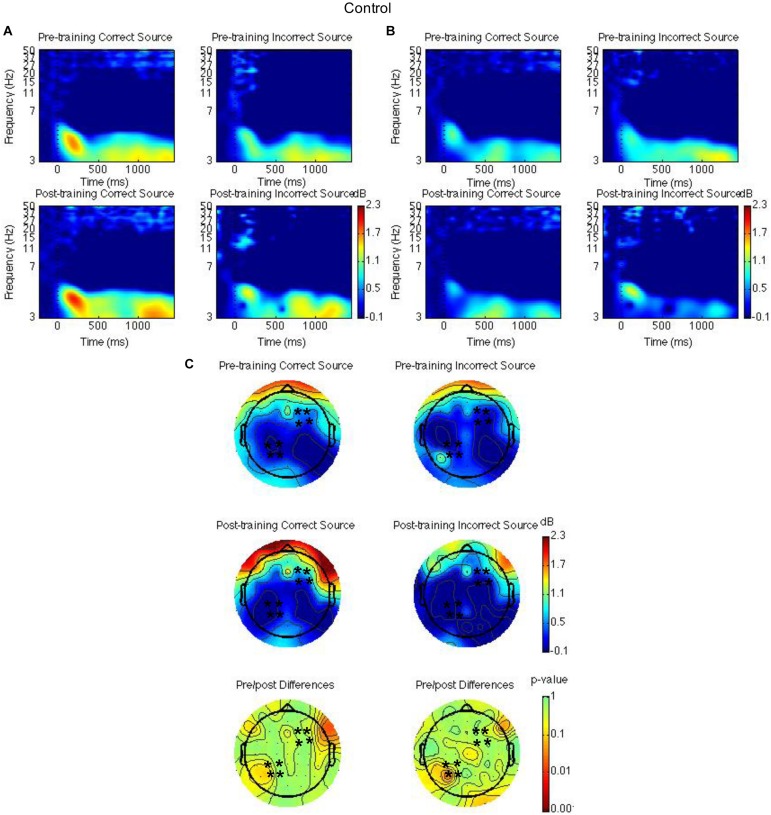
Theta power for the waitlist control group for the pre-training compared to the post-training session for hits with correct source and hits with incorrect source. Time-frequency spectrograms across times and frequencies in a right frontal channel (A). Time-frequency spectrograms across times and frequencies in a left parietal channel (B). Theta power across all channels from 1000 to 1500 ms and differences from pre-training to post-training. Black ∗ marks analyzed channels in right frontal and left parietal regions (C). Color scale: decibel change from pre-stimulus baseline and p-value of pre-training to post-training differences.